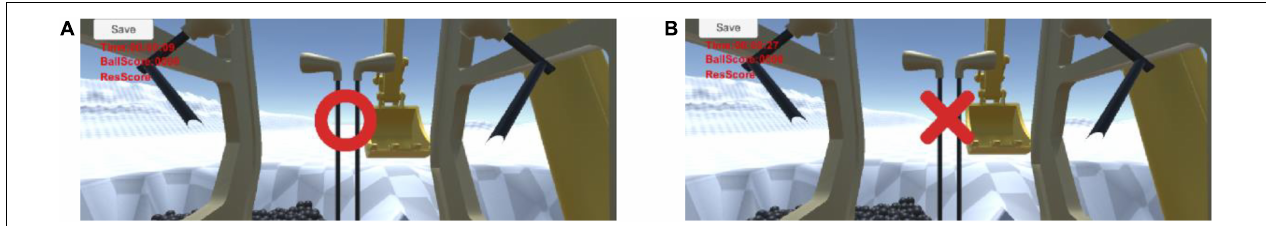
FIGURE 1 | Two types of VA: (A) ring-shaped (B) cross-shaped.